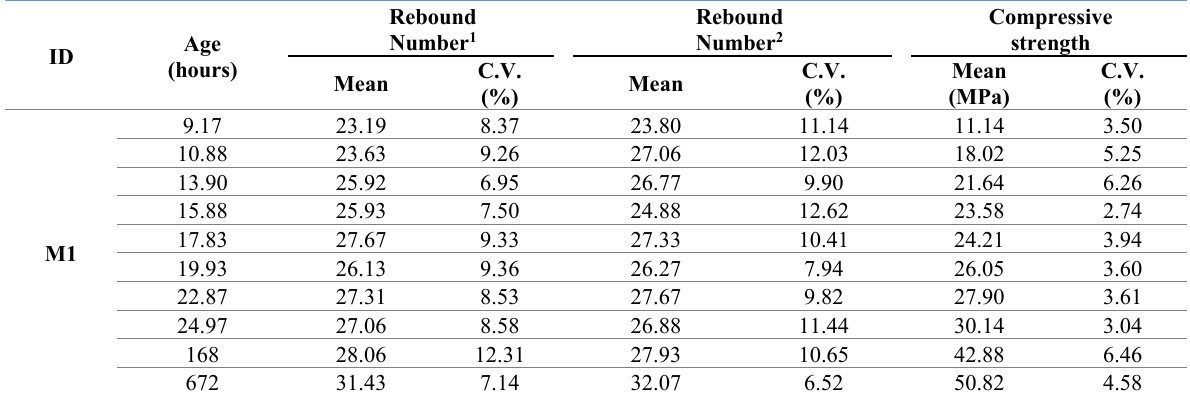
Table 4 – Test results of the second phase of the experimental